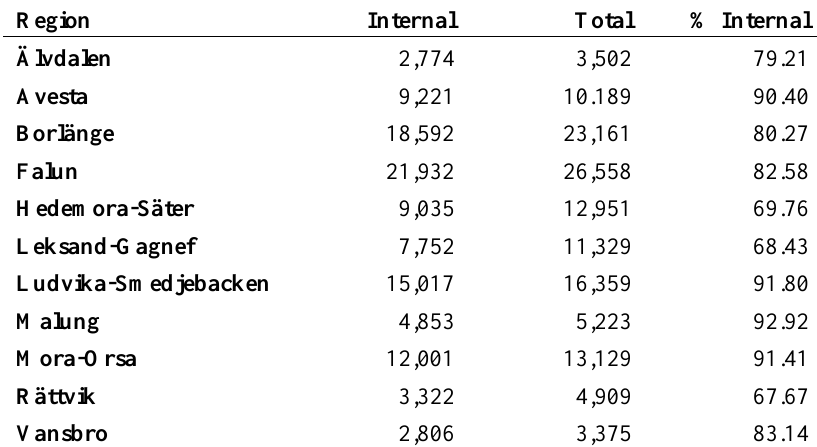
Table 6. Net residence-based self-containment at step 661.